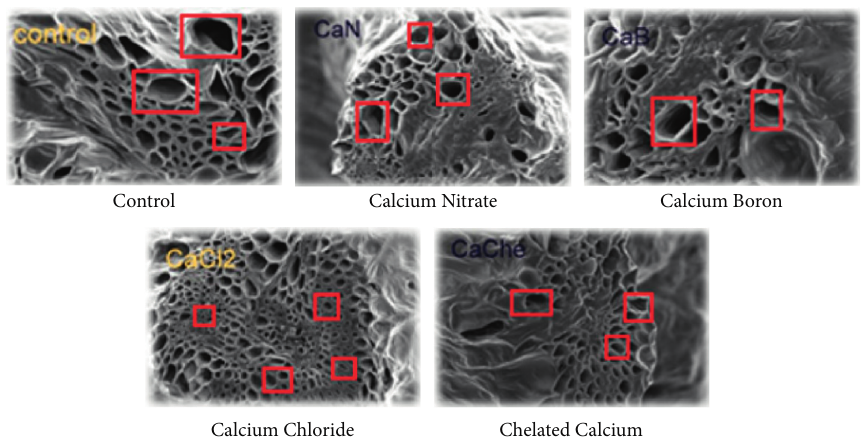
Figure 1: Effect of calcium spray on the pineapple cell walls rigidity as shown in red